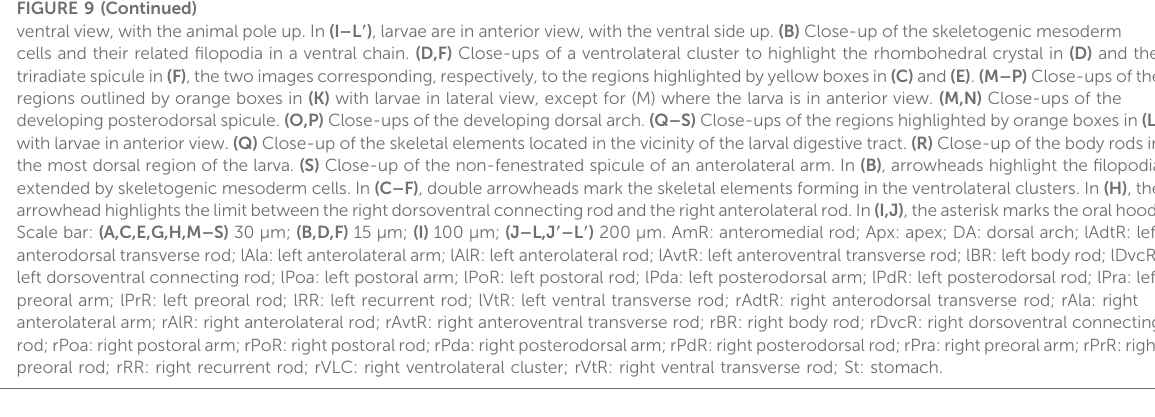
arrowheadhighlightsthelimitbetweentherightdorsoventralconnectingrodandtherightanterolateralrod.In (I,J) ,theasteriskmarkstheoralhood. Scale bar: (A,C,E,G,H,M – S) 30 μ m; (B,D,F) 15 μ m; (I) 100 μ m; (J – L,J 9 – L 9 ) 200 µm. AmR: anteromedial rod; Apx: apex; DA: dorsal arch; lAdtR: left anterodorsal transverse rod; lAla: left anterolateral arm; lAlR: left anterolateral rod; lAvtR: left anteroventral transverse rod; lBR: left body rod; lDvcR: left dorsoventral connecting rod; lPoa: left postoral arm; lPoR: left postoral rod; lPda: left posterodorsal arm; lPdR: left posterodorsal rod; lPra: left preoral arm; lPrR: left preoral rod; lRR: left recurrent rod; lVtR: left ventral transverse rod; rAdtR: right anterodorsal transverse rod; rAla: right anterolateral arm; rAlR: right anterolateral rod; rAvtR: right anteroventral transverse rod; rBR: right body rod; rDvcR: right dorsoventral connecting rod;rPoa:rightpostoralarm;rPoR:rightpostoralrod;rPda:rightposterodorsalarm;rPdR:rightposterodorsalrod;rPra:rightpreoralarm;rPrR:right preoral rod; rRR: right recurrent rod; rVLC: right ventrolateral cluster; rVtR: right ventral transverse rod; St: